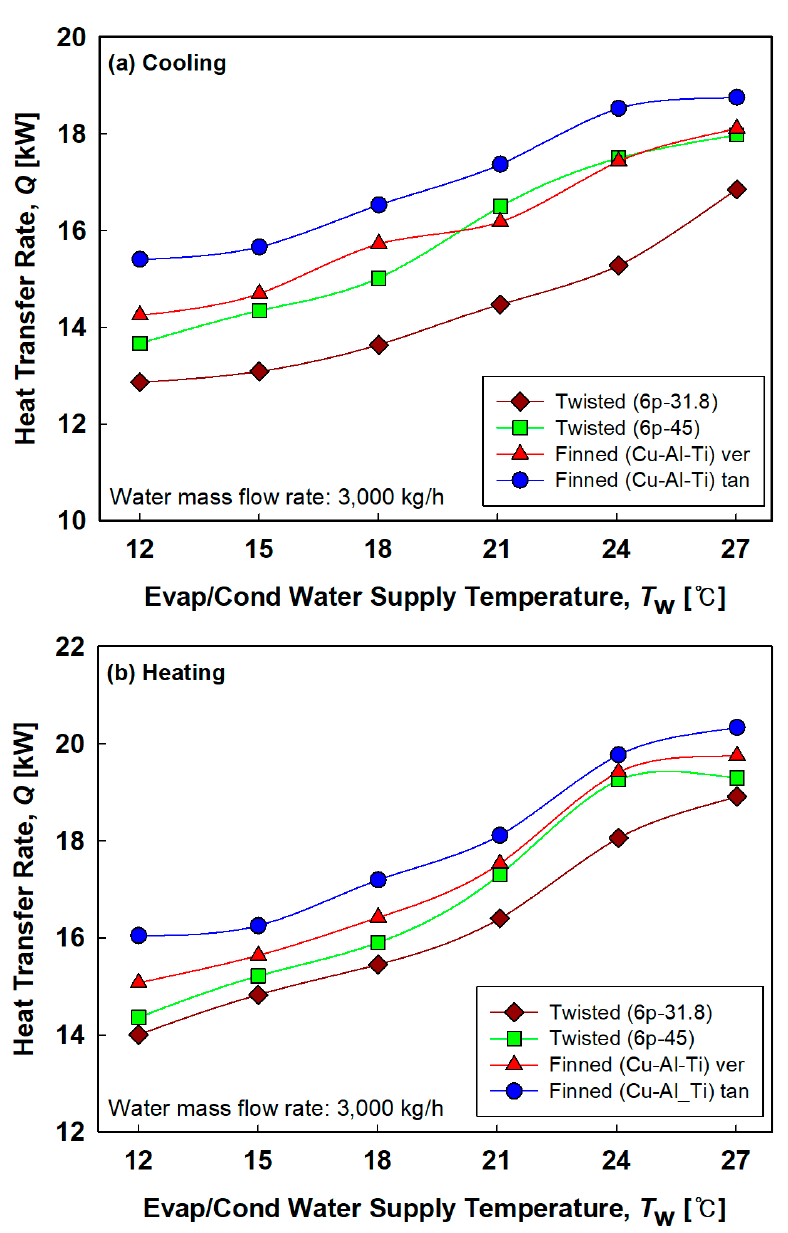
Figure 7. ( a ) Comparison of heat transfer rate between finned and twisted types according to the supplied water temperature: cooling mode. ( b ) Comparison of heat transfer rate between finned and twisted types according to the supplied water temperature: heating mode.